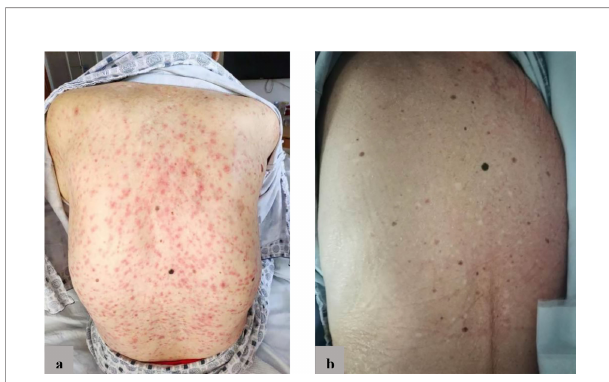
FIGURE 3 | (A) Before treatment: diffuse erythema on the back; (B) After treatment: erythema basically disappeared.